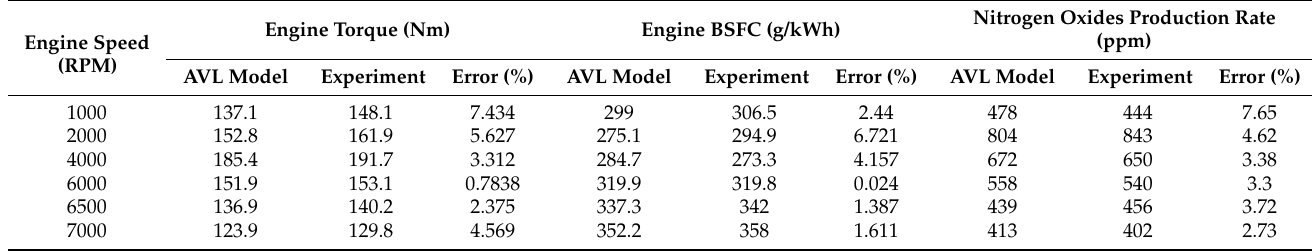
Table 3. Comparison of engine torque, BSFC and nitrogen oxide production rate of AVL model with experimental tests at different engine speeds [3].